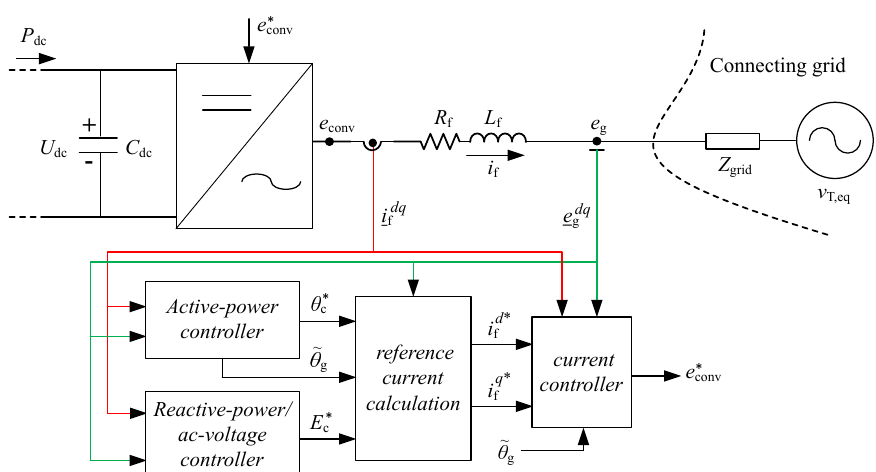
Figure 1. Schematic of the equivalent circuit of a generic converter system connected to a grid through a phase reactor and possible control